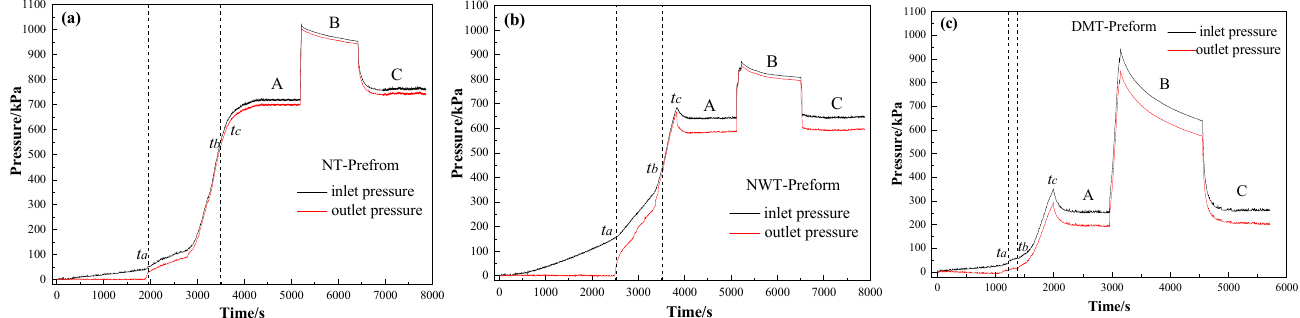
Figure 3. Pressure change laws during z-directional injection. ( a ) NT-Preform; ( b ) NWT-Preform; ( c ) DMT-Preform and stage A means that the inlet open but only outlet of (2-2)# open; stage B means that inlet and all outlets are closed; stage C means that the inlet open but only outlet of (2-2)# open.